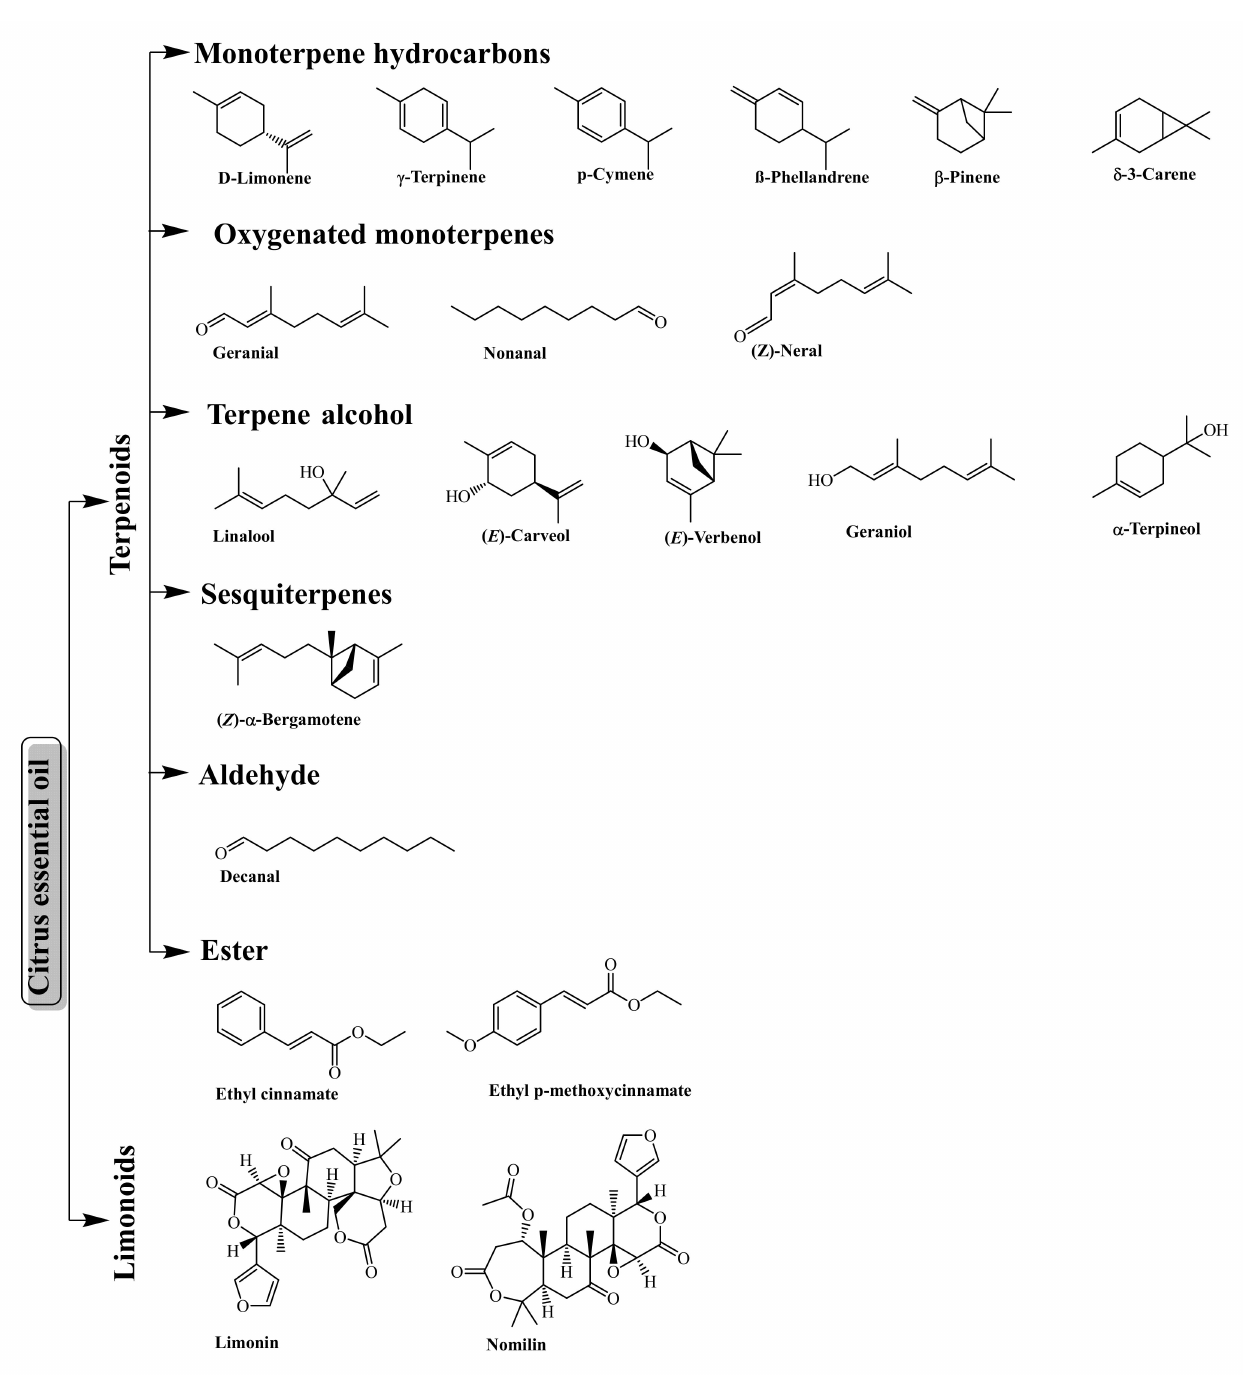
Figure 3. The major bioactive compounds (terpenes and limonoids) of citrus essential